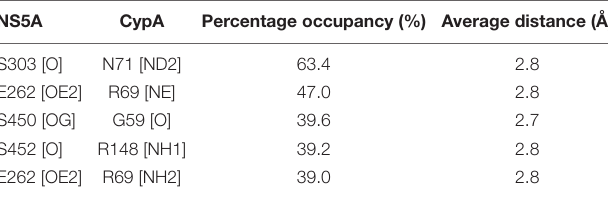
TABLE 2 | H-bond analysis for CyPA:NS5A protein–protein